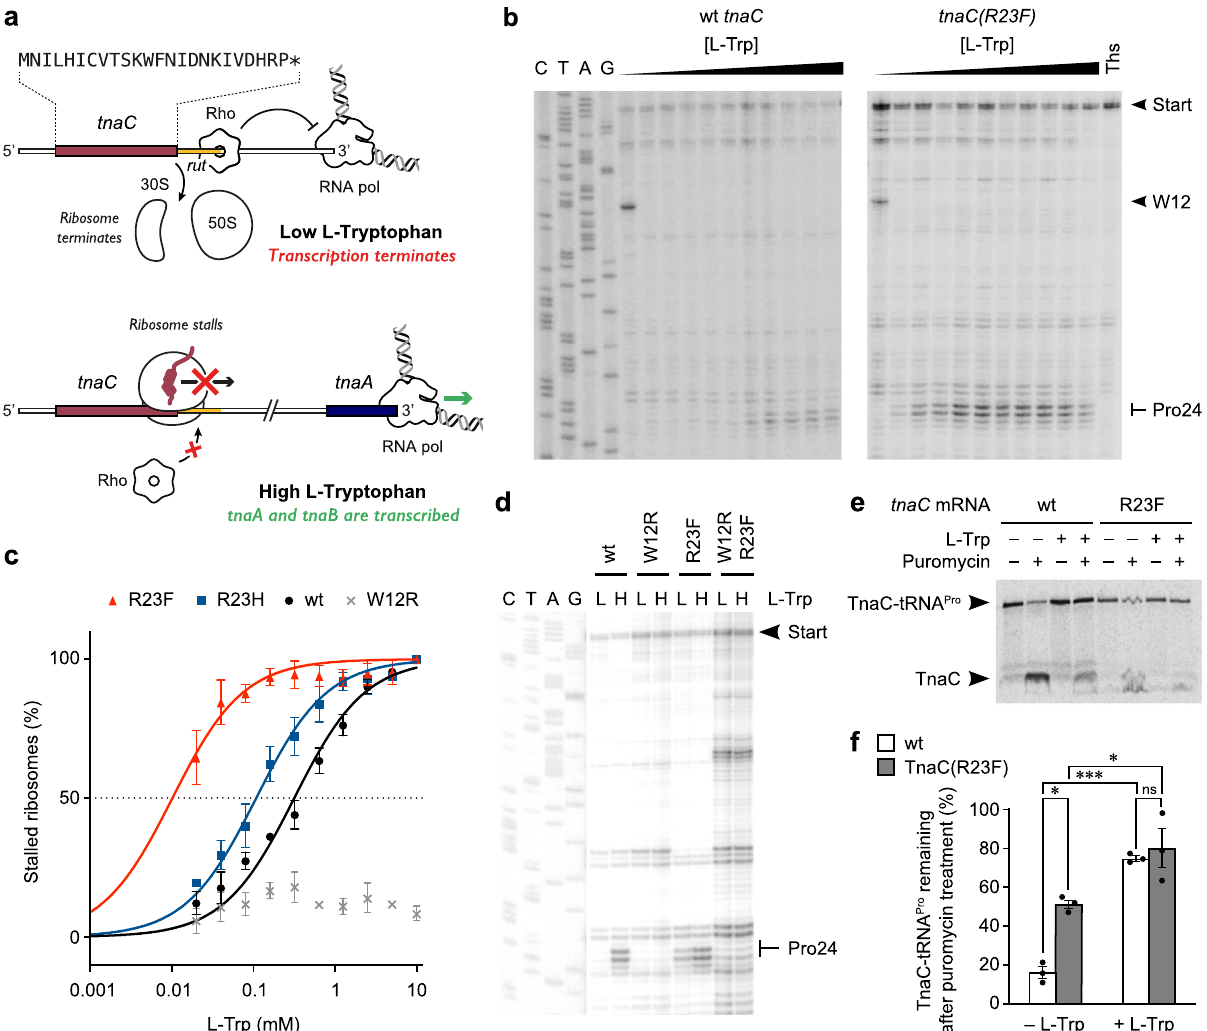
Fig. 1 Biochemical characterization of a TnaC(R23F) variant. a Graphical representation of the mechanism of gene regulation by TnaC. A high concentration of L-Trp stalls the ribosome during translation of tnaC , blocking Rho ’ s access to the rut site and allowing transcription of the complete tnaCAB operon. b Toeprinting assay of tnaC wt and R23F over a range of exogenous L-Trp concentrations (0 – 10 mM). Thiostrepton (Ths), an inhibitor of translation elongation, was used as a control for the detection of arrested ribosomes. These gels are representative of n = 3 independent experiments. c Plot of accumulation of stalled ribosomes as a function of L-Trp concentration. Each data point represents the average of n = 3 independent experiments. [L-Trp] 0.5 values (concentration of L-Trp required to reach 50% of maximum enzyme activity) were calculated using a nonlinear fi t model where each plot has a coef fi cient of determination above 0.96. Data are presented as mean values + / − SEM. d Toeprinting assay of tnaC variants featuring arginine (wt) or phenylalanine (R23F) codons at position 23, as well as W12R or W12R-R23F mutations. Reactions were performed with 0.0125 mM (L) or 5 mM (H) L-Trp. This gel is representative of n = 2 independent experiments. e Radiogram of resolved products of puromycin-induced cleavage of [ 35 S]-methionine labeled TnaC-tRNA molecules. The complexes were incubated with ( + ) or without ( − ) 4 mM L-Trp and later incubated with ( + ) or without ( − ) 1 mM puromycin. Arrows indicate the position of the [ 35 S]-methionine TnaC-tRNA Pro and TnaC-puromycin (TnaC) products. The far-left lane shows the positions of control molecules for this experiment. This gel is representative of n = 3 independent experiments. f Bar plot indicating the relative remaining amount of TnaC- tRNA Pro in the wild-type and R23F mutant complexes after treatment with puromycin. A two-way ANOVA statistical test was performed to determine signi fi cance in differences across all data using a threshold of P < 0.05. *** P < 0.001; * P = 0.023; ns, non-signi fi cant difference. These results are indicative of n = 3 independent experiments. Data are presented as mean values + / −